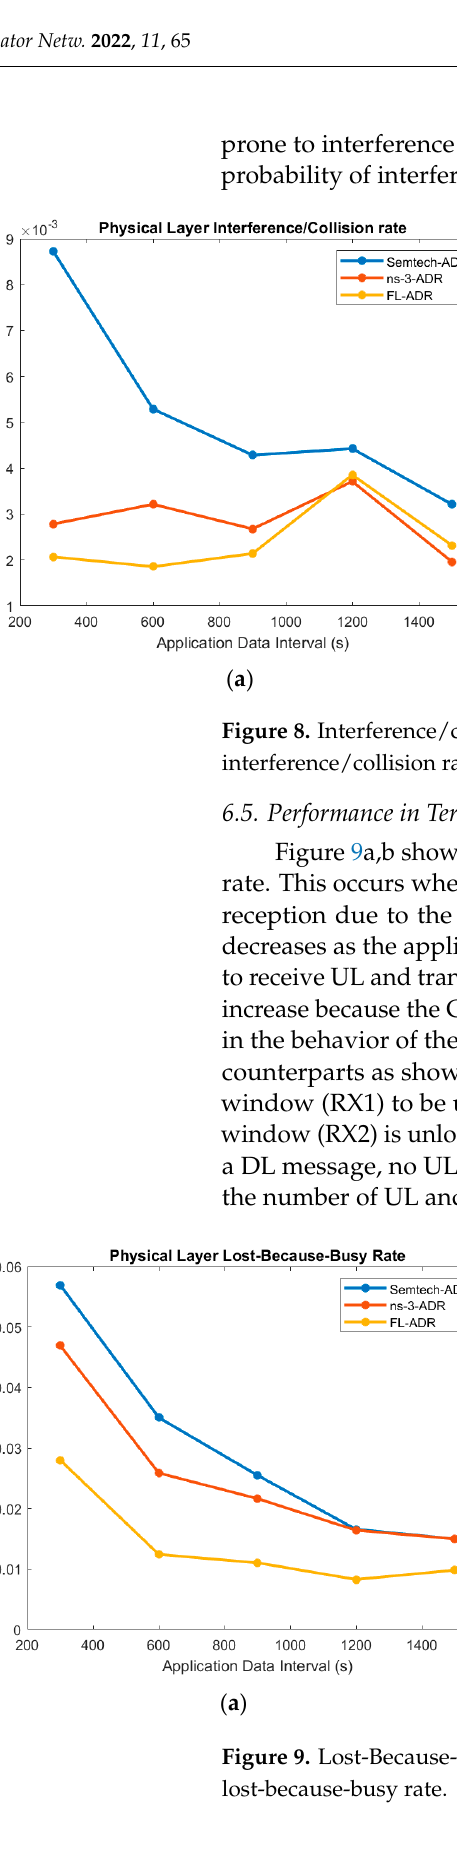
Figure 8a,b shows the performance of the three different ADR schemes considering